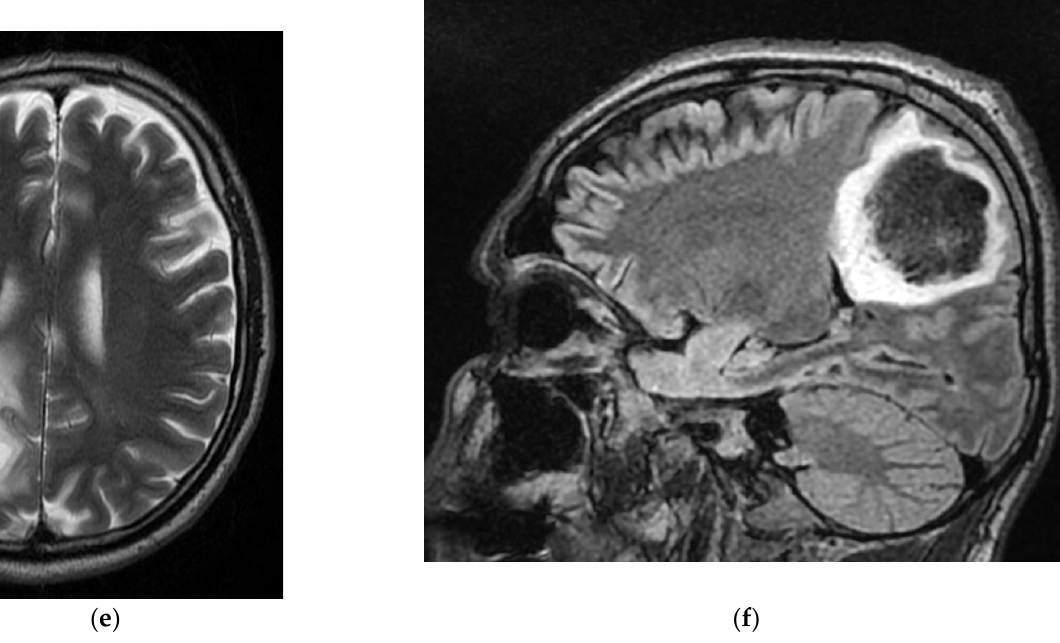
Figure 9. MRI images of the Case 9 patient show oval mass with liquid content ( a , b ) and normal diffusion of water ( c , d ), located in the right parietal subcortical area; the lesion described is circum- scribed and crossed by very thin vascular lines ( e ), and does not communicate with the ventricles nor with the subarachnoid space, associates with the perilesional foreshores of the intense FLAIR signal ( f ), and has a slight mass effect on the right lateral ventricle ( e ). In conclusion, the findings revealed a right parietal cystic expansive process.